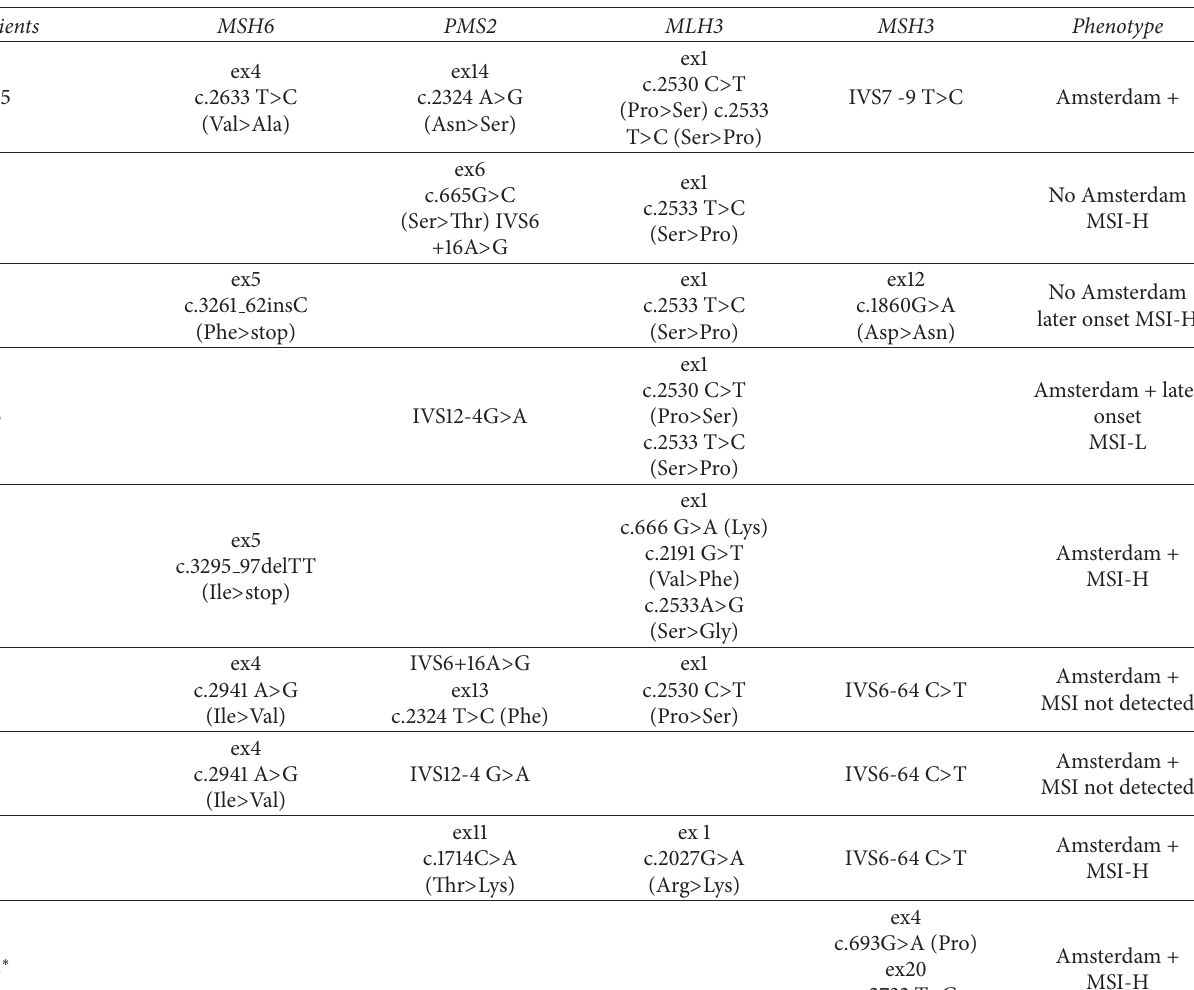
Table 3: Patients carrying variants in several MMR genes: MSH6, PMS2, MSH3, and MLH3; ∗ patient 504 showing also the UV in MSH2 gene (c.984 C > T)